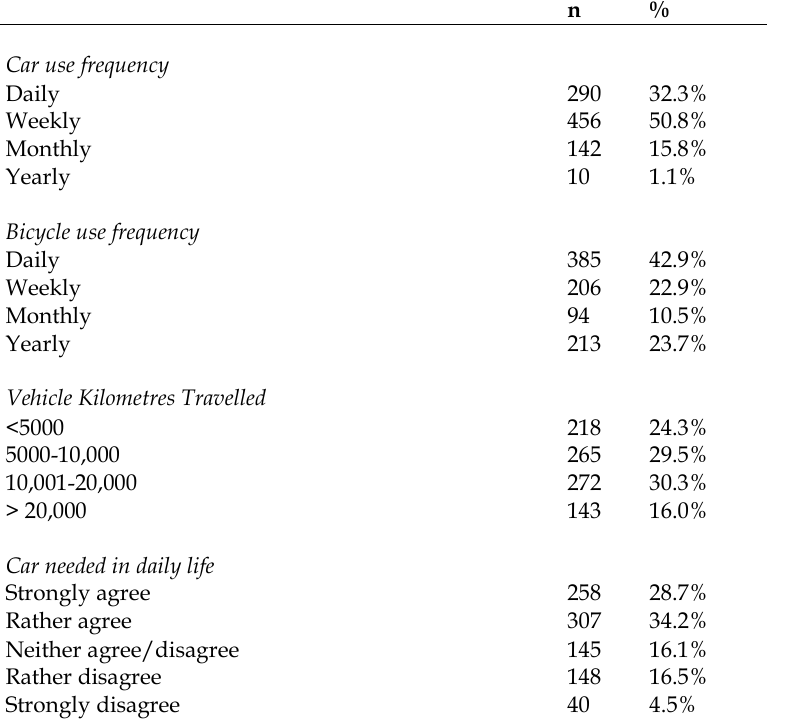
Table 1: Constituent variables overall sample (n=898)